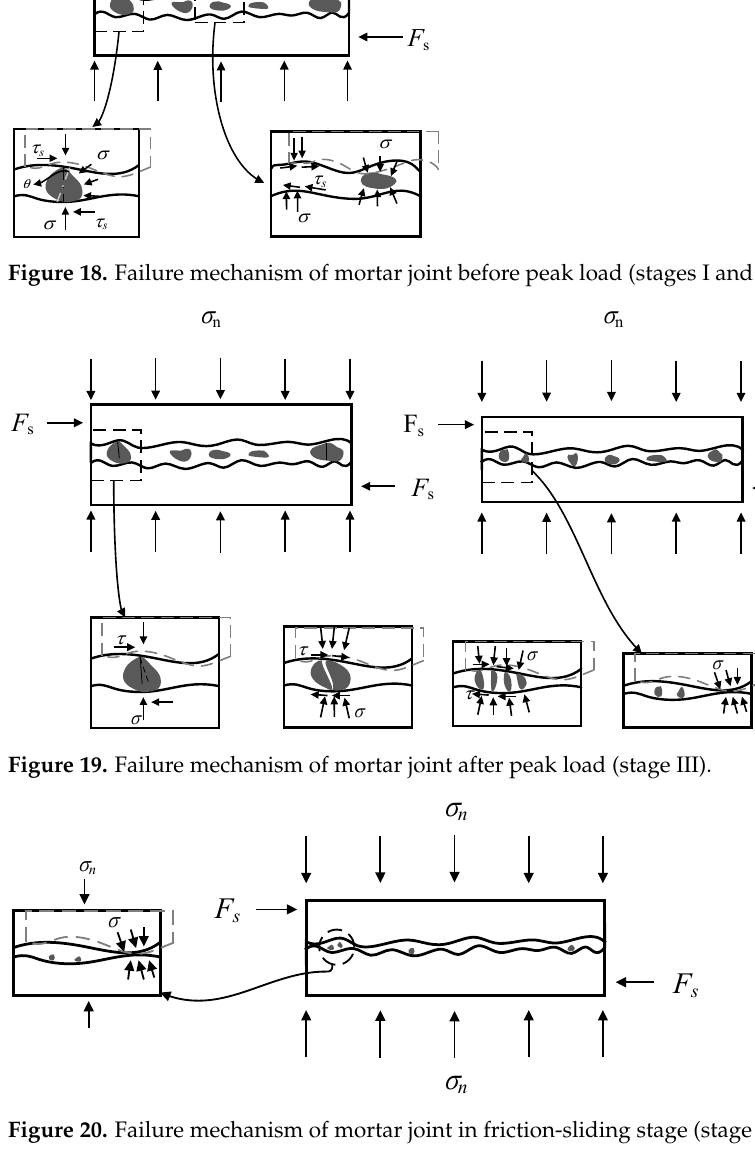
Figure 20. Failure mechanism of mortar joint in friction-sliding stage (stage Ⅳ ).